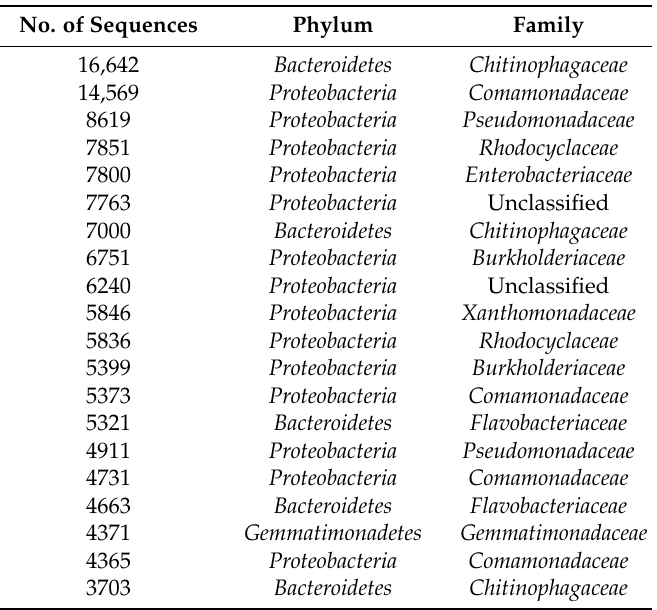
Table A3. The taxonomy of dominant OTUs (>1% of all 368,775 sequences after subsampling) at phylum and family level.